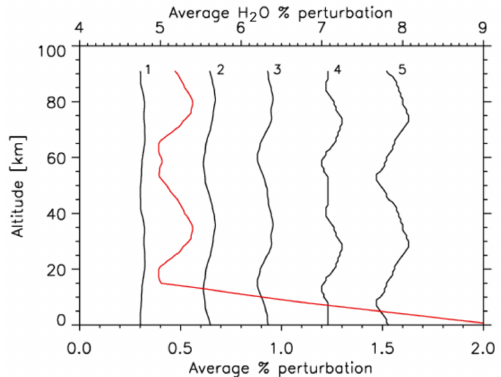
Figure 3. Average % values (over 20 GMTR runs) of pert ( h ) cor- responding to different values of B in Eq. (1). The value of B is reported on top of each line except for the red line that refers to H 2 O perturbations and is measured by the upper scale. In this case B is 30 at 0km and linearly decreases up to 15km where it assumes the constant value of